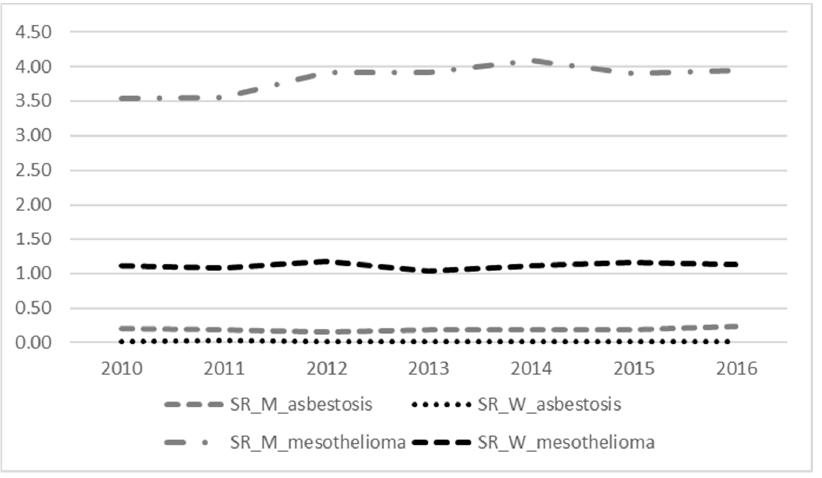
Figure 1. Temporal trend of standardized mortality rates (SR) from malignant mesothelioma and asbestosis (main cause of death) in Italy. Period 2010–2016. (M: men, W: women).